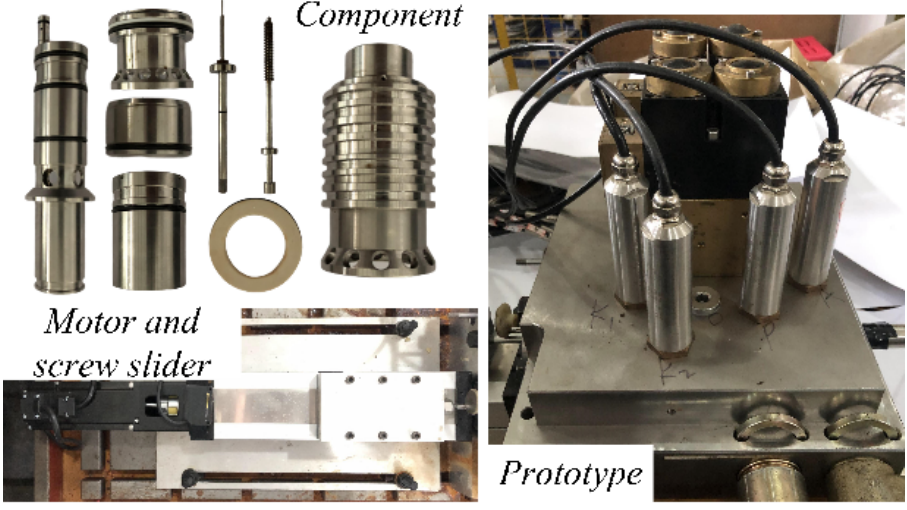
Figure 5. The proportional valve prototype.